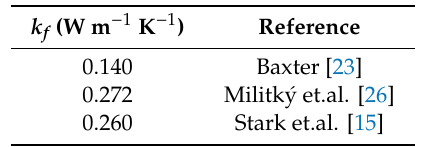
Table 4. Thermal conductivity of polyester fibers in the literature.